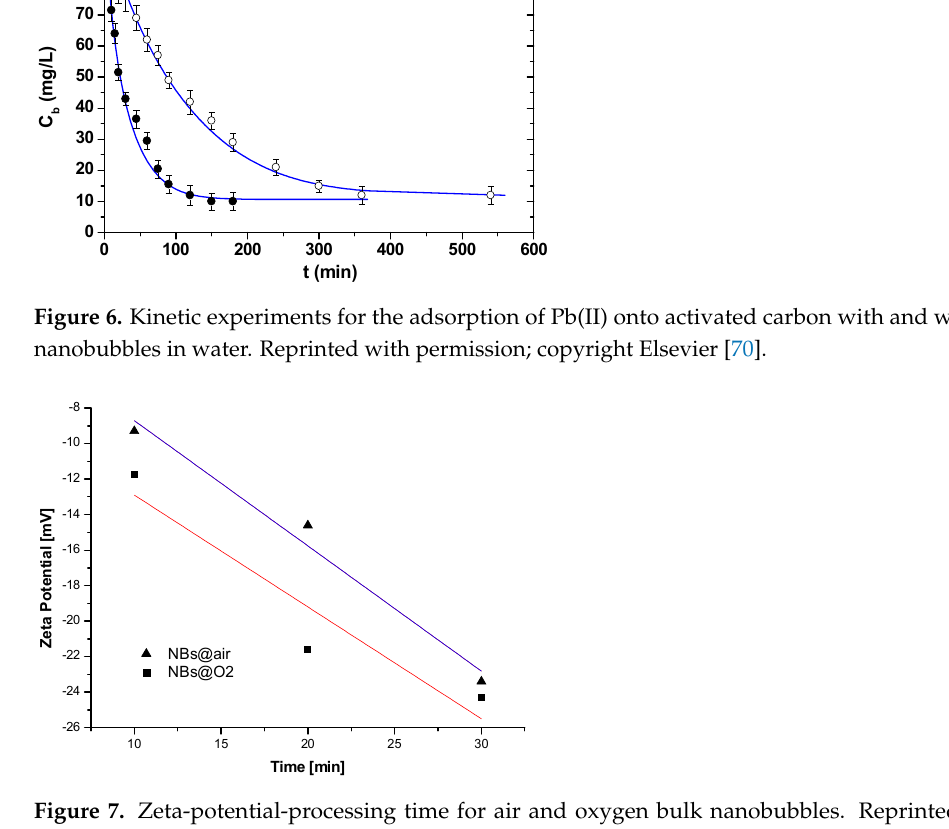
Figure 7. Zeta-potential-processing time for air and oxygen bulk nanobubbles. Reprinted with permission; copyright Elsevier [71] .